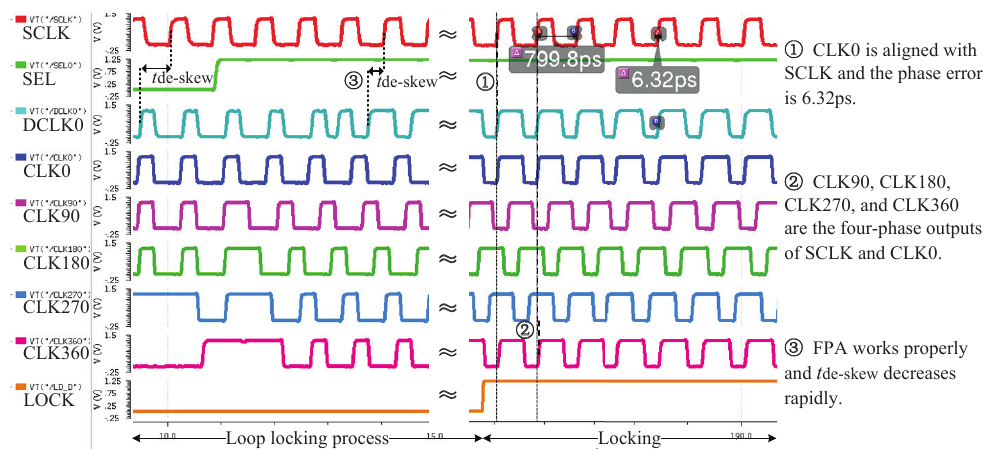
Figure 15. The locking process of four-phase DLL without de-skew circuit at f clock = 1.25 GHz.